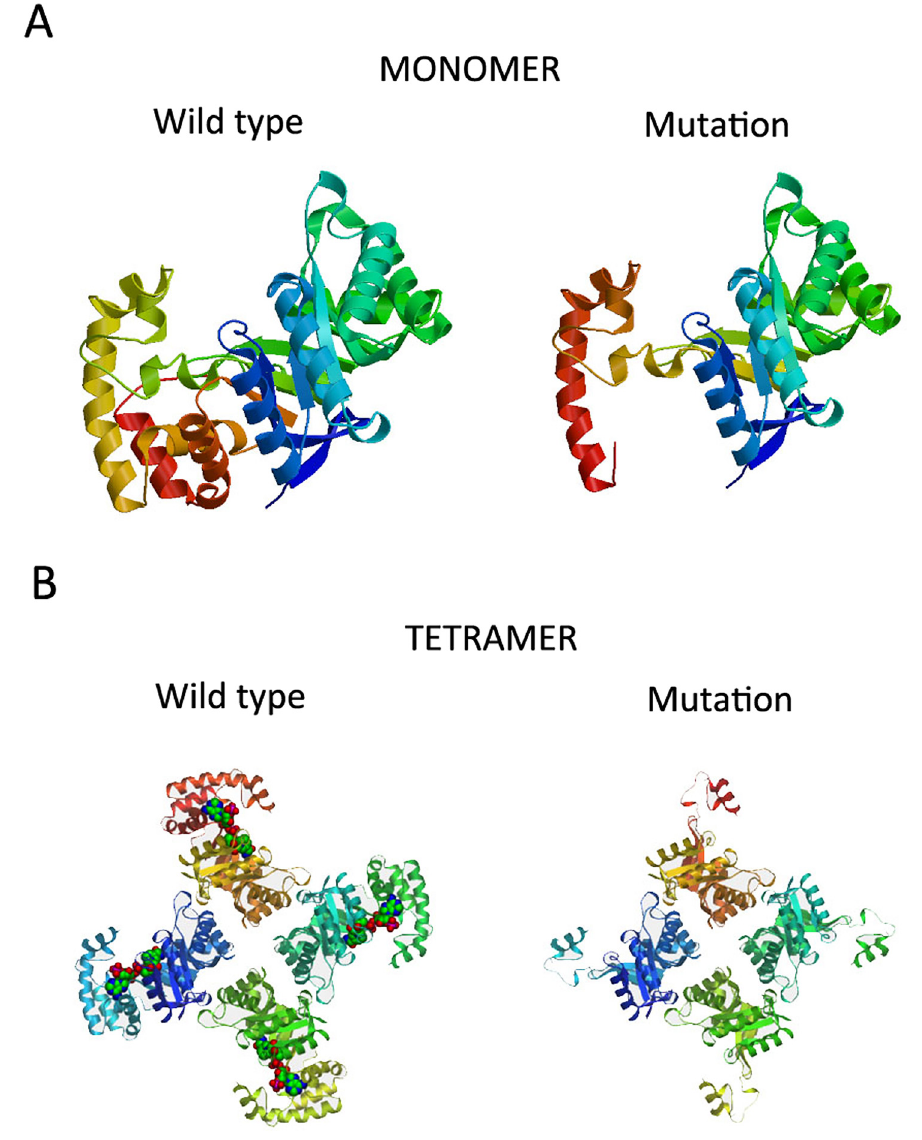
Fig 2. Structure modeling of wild type and p.Leu355HisfsTer5 mutation of KCNAB1 with SWISS-MODEL. A: Monomer view: comparing with wild type, the mutant lost C-terminal structure of the protein; B: Tetramer view: comparing with wild type, the mutant might lose the ability of binding NADP +